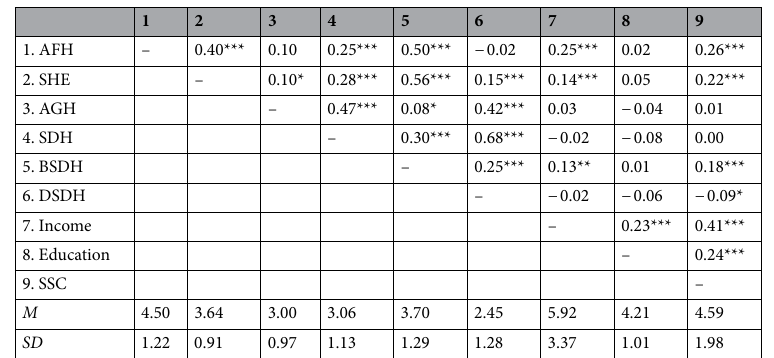
Table 3. Means, SDs, and zero-order correlations among study variables. N = 607. AFH affiliative humor, SHE self-enhancing humor, AGH aggressive humor, SDH self-defeating humor, DSDH deleterious SDH,